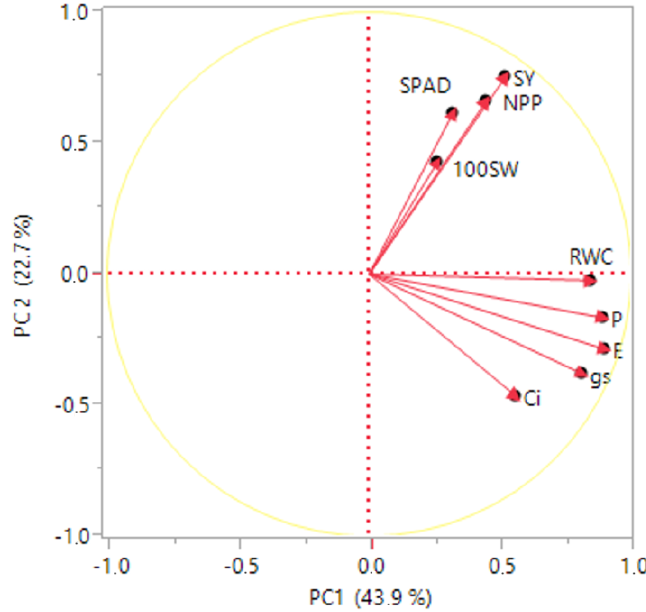
Figure 3. Principal component analysis (PCA) for SY, seed yield (g plant − 1 ); NPP, number of pods plant − 1 ; NSP, number of seeds pod − 1 ; 100SW, 100 seed weight; RWC%, relative water content; SPAD, chlorophyll content; P n , net photosynthetic rate; g s , stomatal conductance; C i , intercellular CO 2 concentration; E, transpiration rate. Table 4. Correlation coefficients for SY, NPP, NSP, 100SW, RWC (%), SPAD, P n , g s , C i , E of the ten bean genotypes as affected by three irrigation levels [normal irrigation (N), water stress during anthesis (WDA) and water stress during seed filling stage (WDSF)] over two years (2014–2015). Correlations coefficients (n = 10) superscripted with * or ** were significant at p ≤ 0.05 or 0.01.